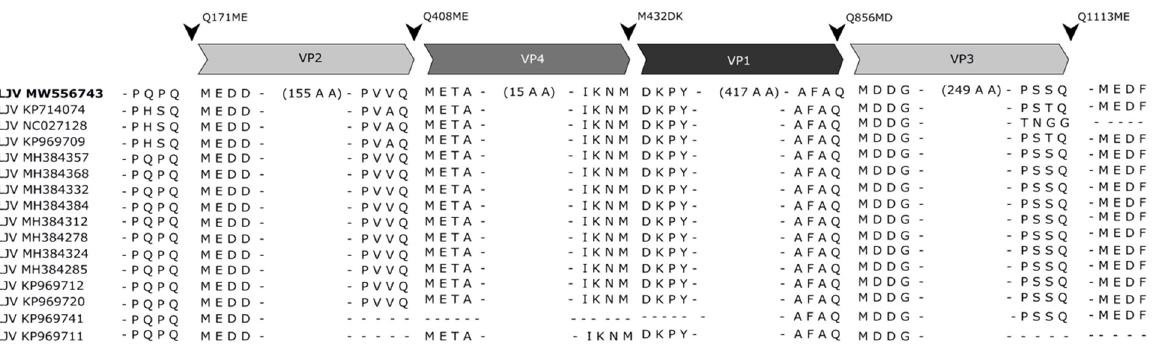
Figure 8. Organization of the structural protein region in the polyproteins of different strains of La Jolla virus (LJV). The capsid proteins (VP2, VP4, VP1 and VP3) are indicated in grayscale. Arrowheads mark cleavage sites as annotated.